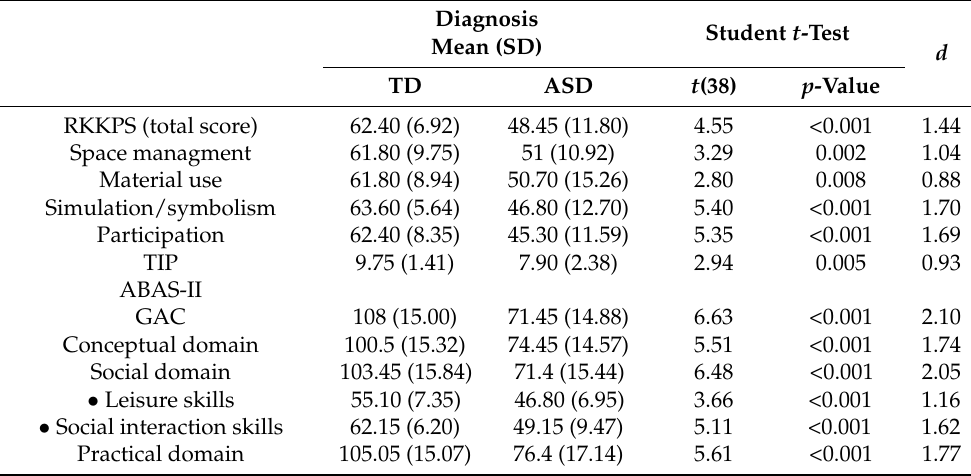
Table 2. Means, standard deviations, t -test and effect size of measures between groups.